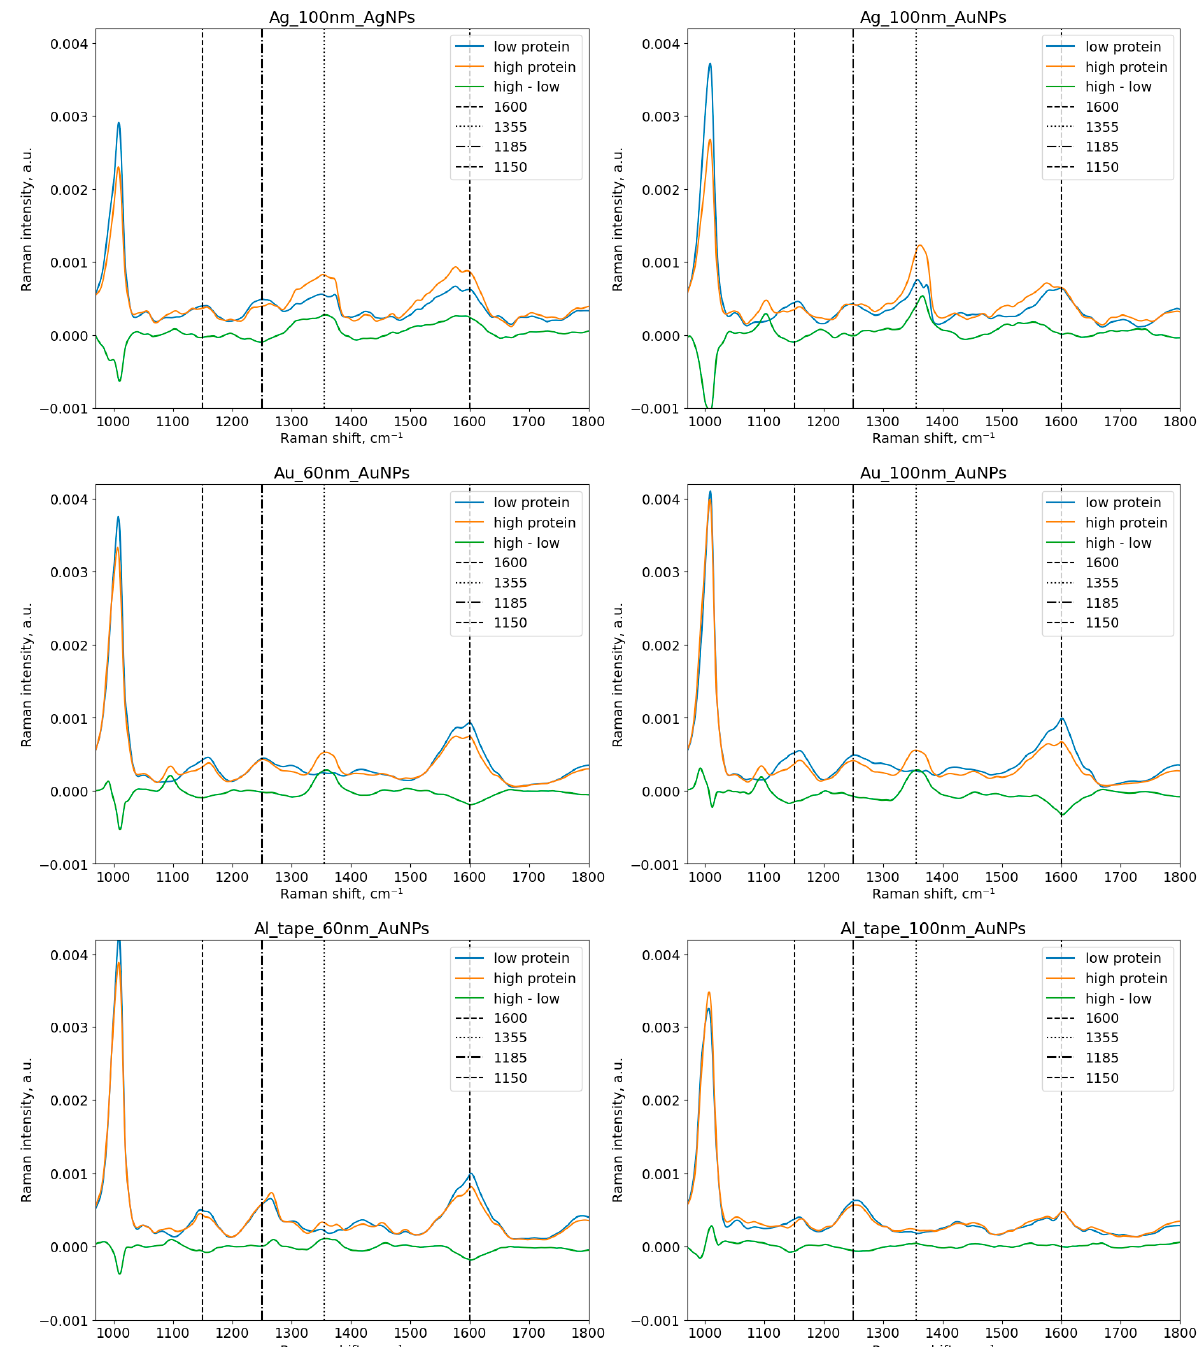
Figure 4. Average SERS spectra of urine samples with the low and the high protein groups with the spectrum of their difference for the metal substrates. The protein threshold is 300 mg/L. Au_100nm_AuNPs means 100 nm Au NPs on the gold substrate.